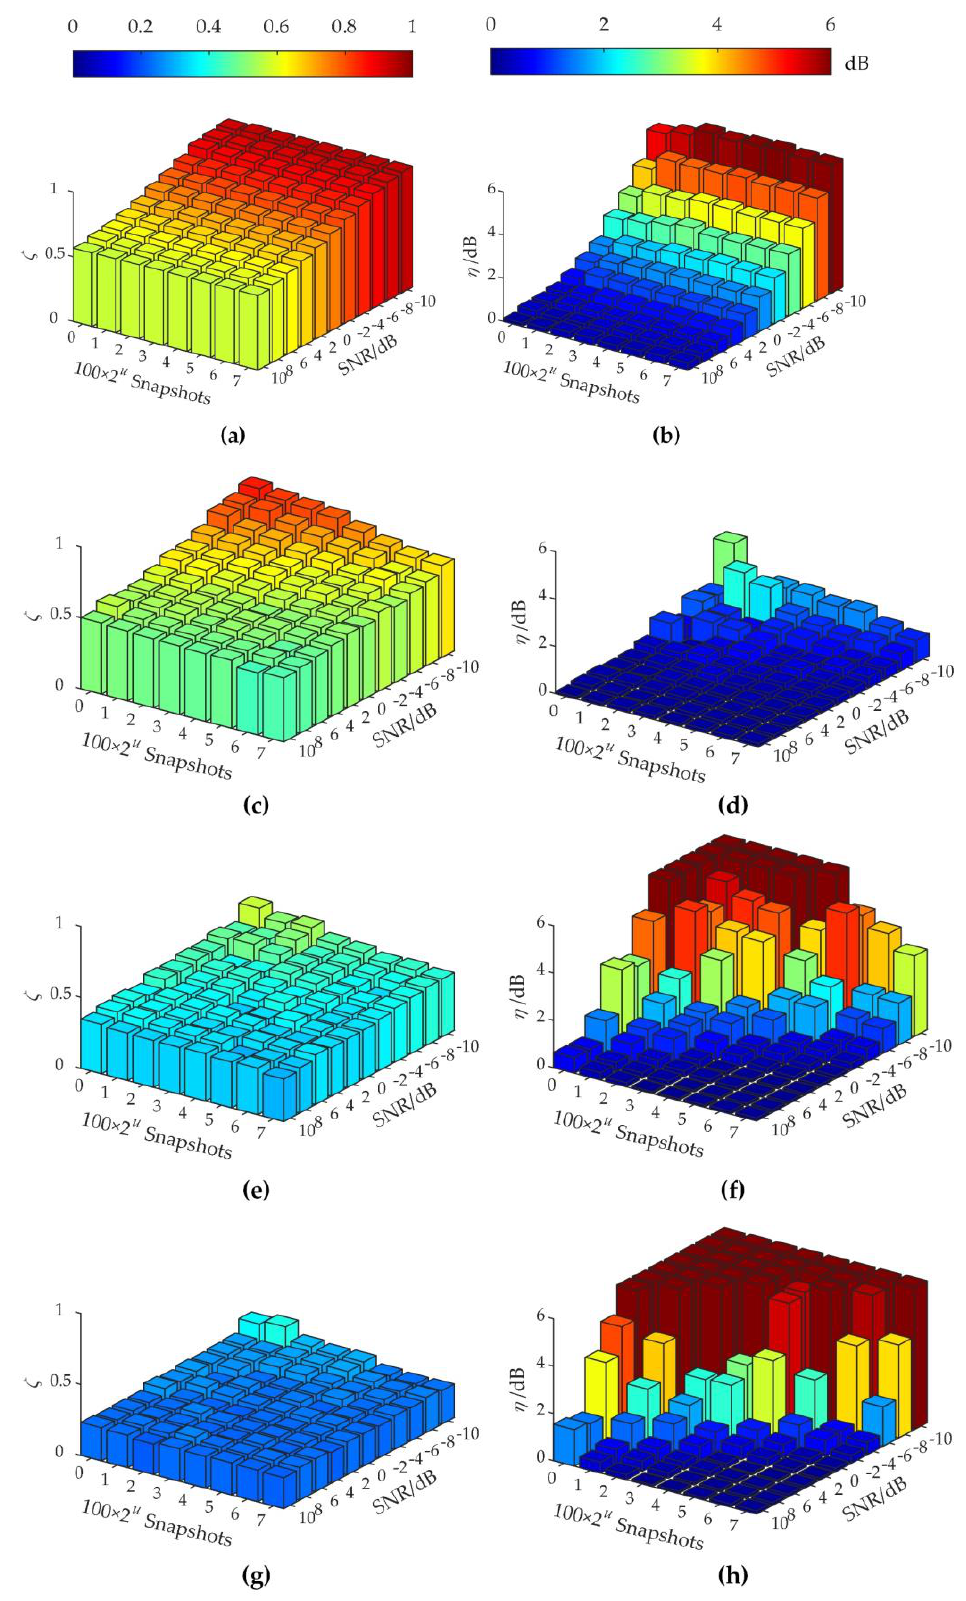
Figure 6. Acoustic imaging errors: ( a , c , e , g ) The difference coefficients of FDAS, EFDAS-DRec, EFDAS-RPCA, and EFDAS-PFA, respectively; ( b , d , f , h ) The average quantification errors of FDAS, EFDAS-DRec, EFDAS-RPCA, and EFDAS-PFA, respectively.